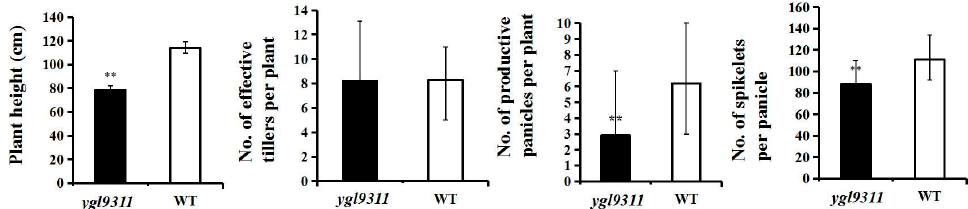
Figure 1. Phenotypic characterization of the mutant ygl9311 . ( A ) Plants at seedling stage. ( B ) Plants at mature stage grown in Hainan.